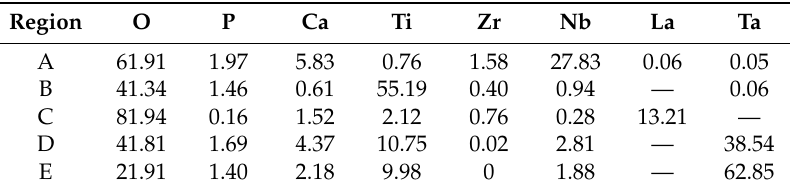
Figure 13. SEM micrographs of shear fracture surfaces of ( a ) 1.0-GNFs; and ( b ) 1.5-GNFs nanocomposites sintered at 1000 ◦ C, respectively. Table 3. The EDS results (at %) for regions A–E in Figure